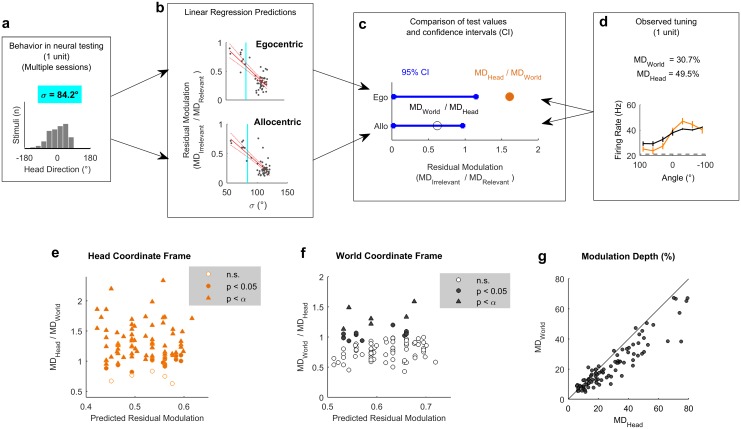
Modulation depth across coordinate frames.a-d: Workflow illustrating the use of animal behavior (a: summarized using the standard deviation of head directions during neural testing, σ) and linear regression models (b: see also Fig 3) to generate confidence intervals (CIs) for residual modulation (c) that were compared to observed modulation depth values (d), normalized relative to the alternative coordinate frame. Blue vertical lines in (b) show the σ value in (a). e-f: Normalized modulation depth observed for each spatially tuned unit compared against the mean residual modulation predicted from behavior in head (e) or world (f) coordinate frames. Bonferroni-corrected statistical criterion (p = 5.43 x 10−4) is denoted by α. g: Modulation depth for all spatially modulated units (n = 92) compared in world (MDWorld) and head coordinate frames (MDHead) during exploration. Data available at https://doi.org/10.6084/m9.figshare.4955342.v1.